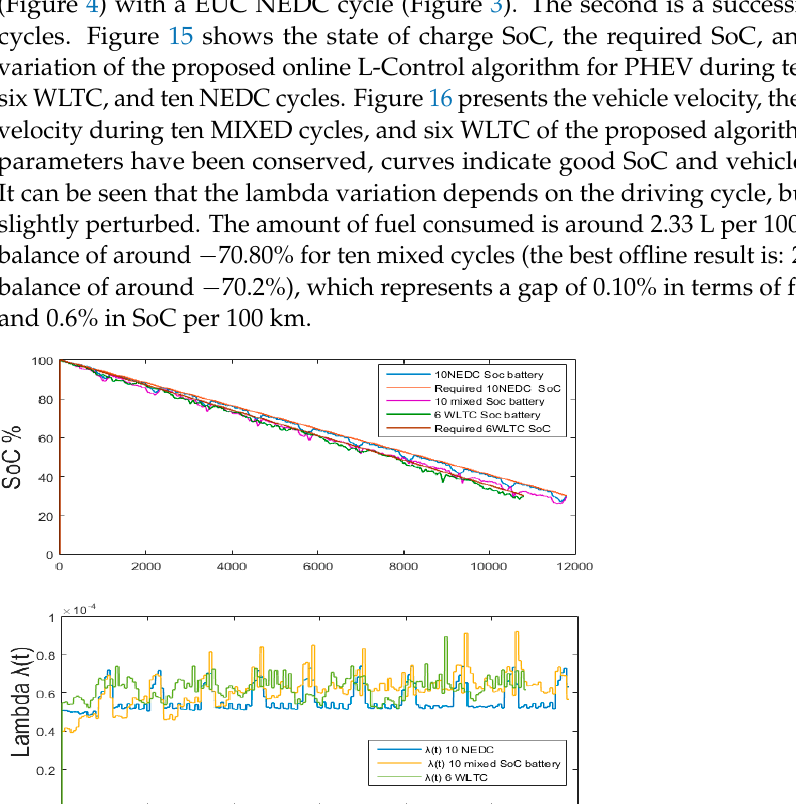
Figure 16. Vehicle velocity and required velocity variation of the proposed online L-Control algo- rithm for PHEV during 10 MIXED cycles, 6 WLTC, and 10 NEDC cycles. 5. Conclusions This article presents an efficient λ -control for an energy management strategy for PHEV derived from the PMP method. It has been extended from λ -control for HEV in charge-sustaining mode to be adequate for offline/online applications in the blended mode for parallel PHEV configuration. Offline-developed control uses a bisection method